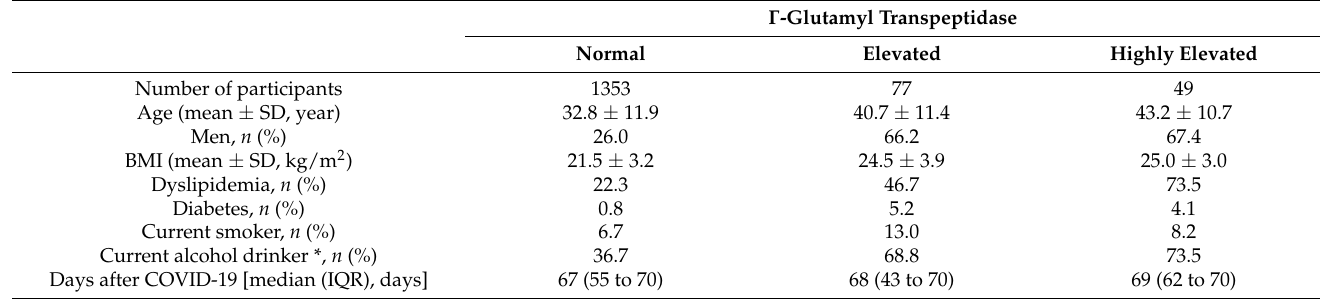
Table 1. Participants’ characteristics according to γ -glutamyl transpeptidase level